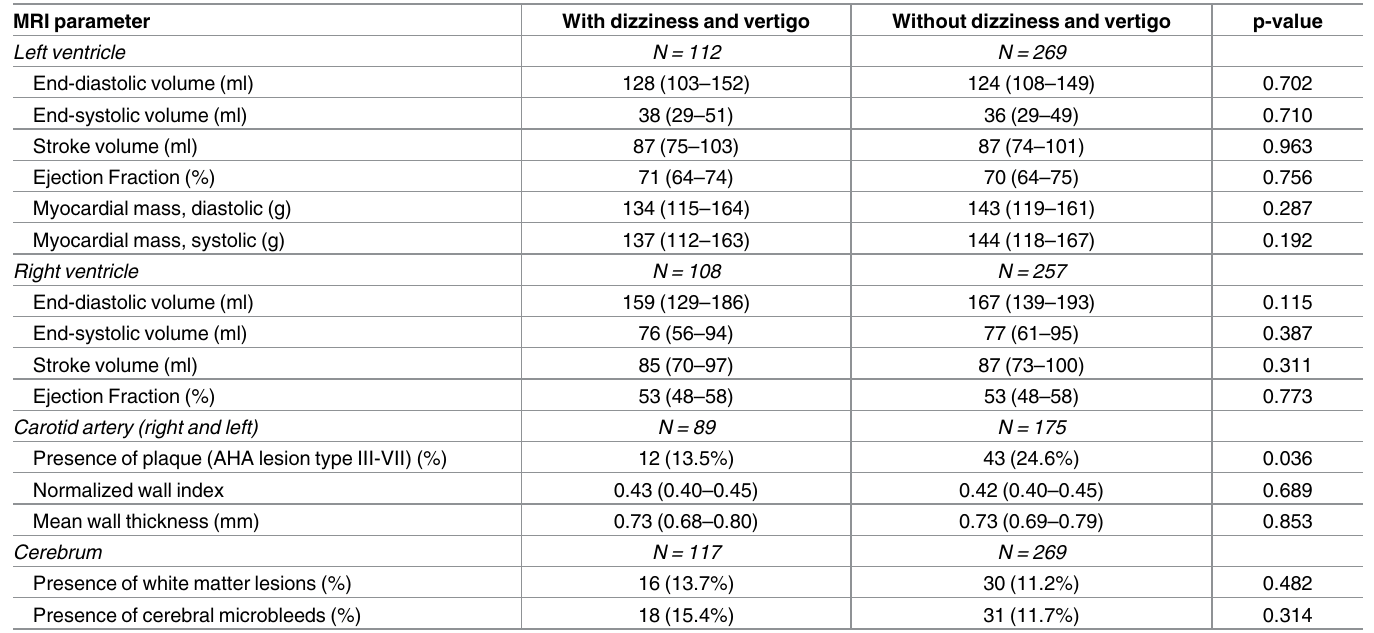
Table 2. Cardiovascular MRI characteristics of the study sample according to lifetime prevalenceof dizziness and